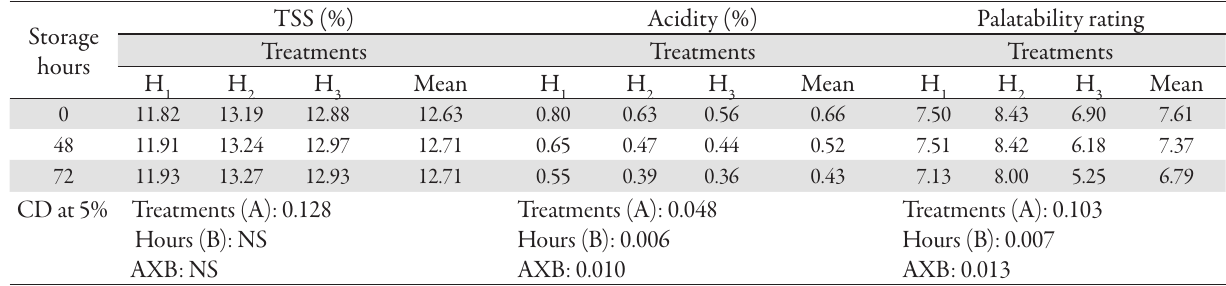
Tab. 1.Total soluble solids, acidity and Palatability rating of peach fruits during post-cold storage ambient shelf life after 48